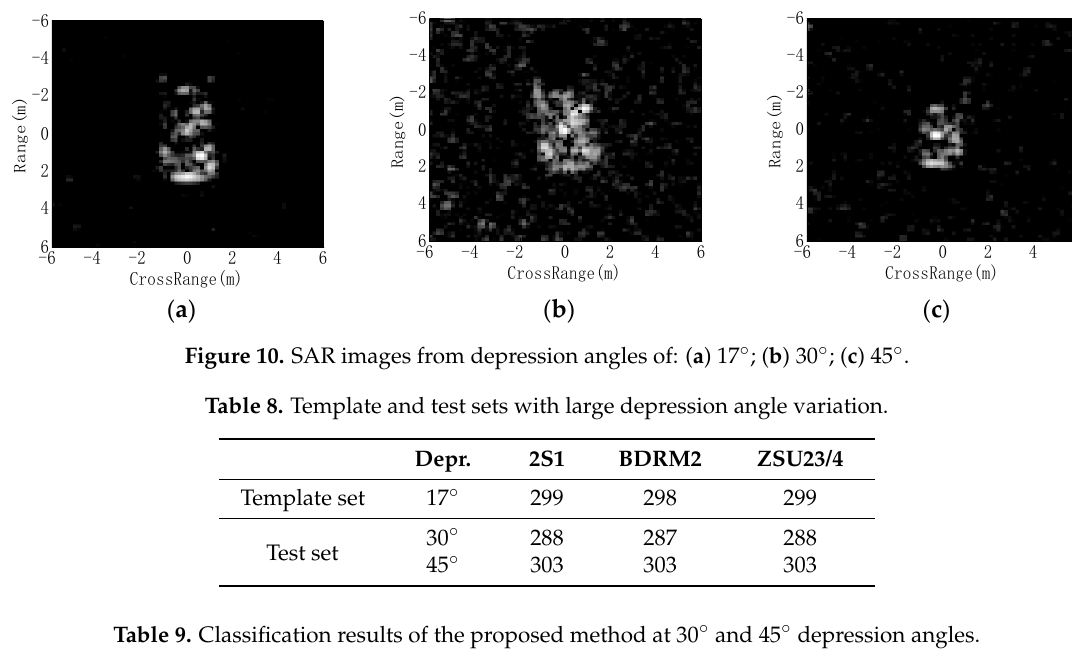
Table 9. Classification results of the proposed method at 30 ◦ and 45 ◦ depression angles. Depr.